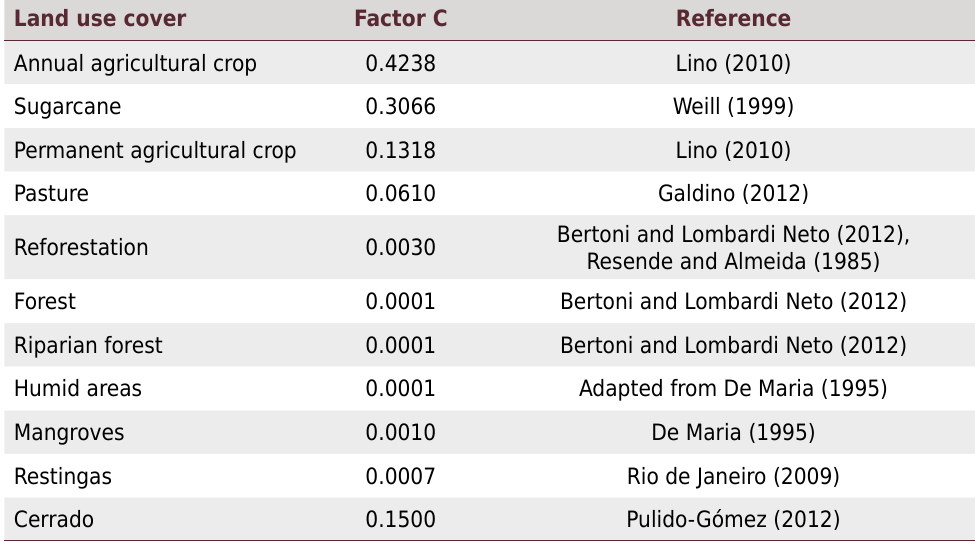
Table 1. C-factor for each land use cover class of the state of São Paulo in 2005 Land use